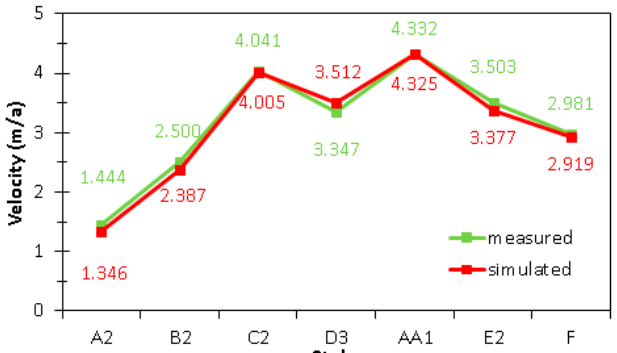
Figure 10. The comparison of the simulated and measured (May 2016-Sep., 2018) velocities (m/a) of 7 stakes along the central flow line. The different colors denote measured or simulated measurements.